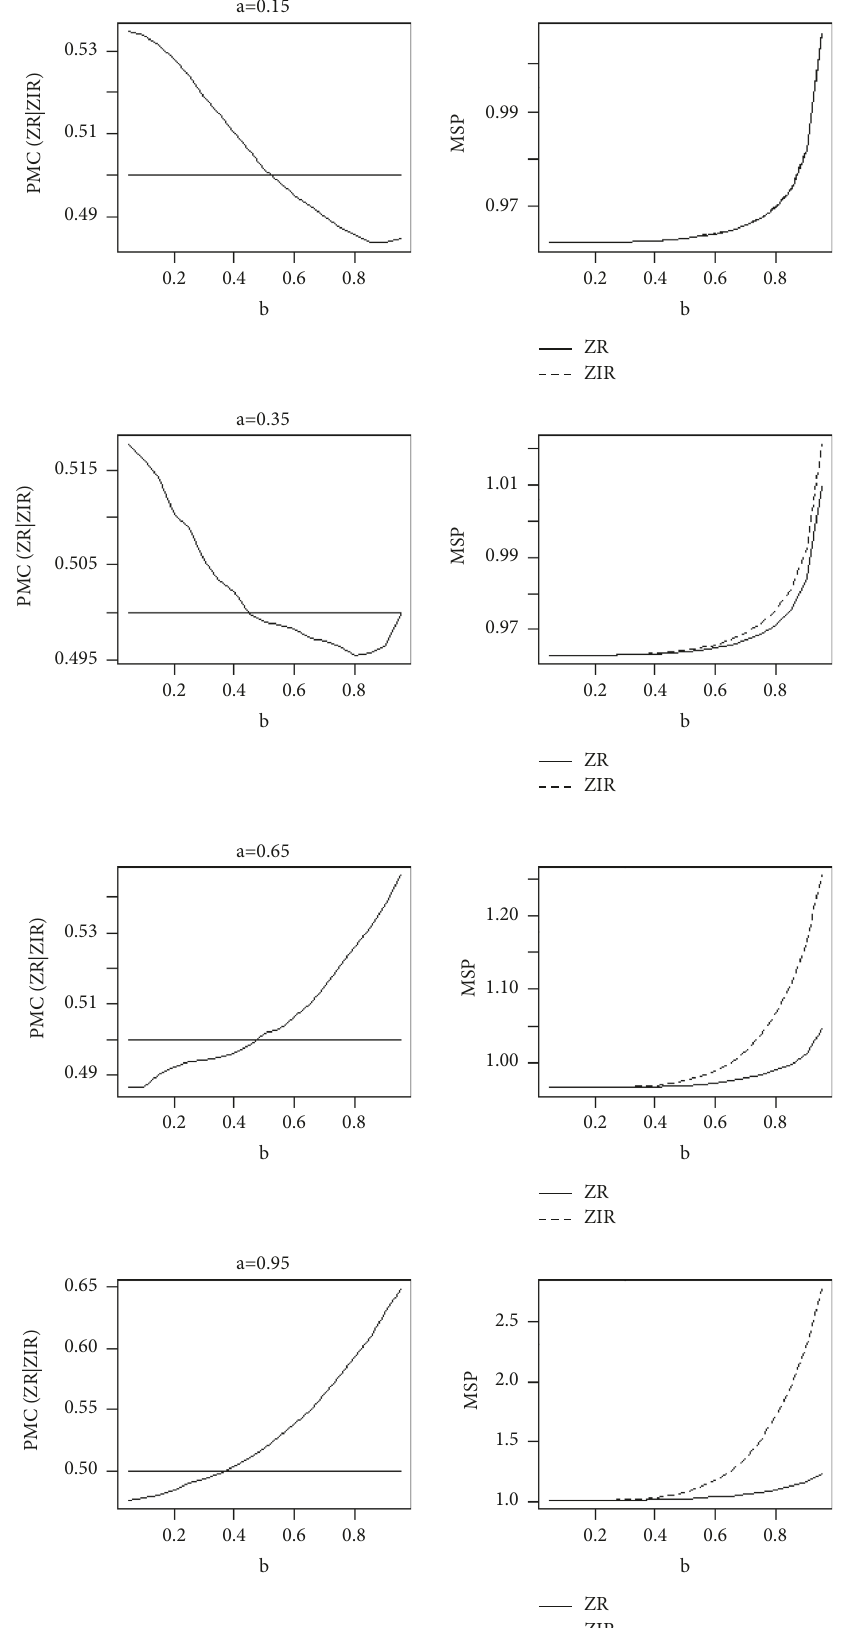
Figure 7: Comparison between 􏽢 Z R and 􏽢 Z IR with exponential errors for some fixed b and all a